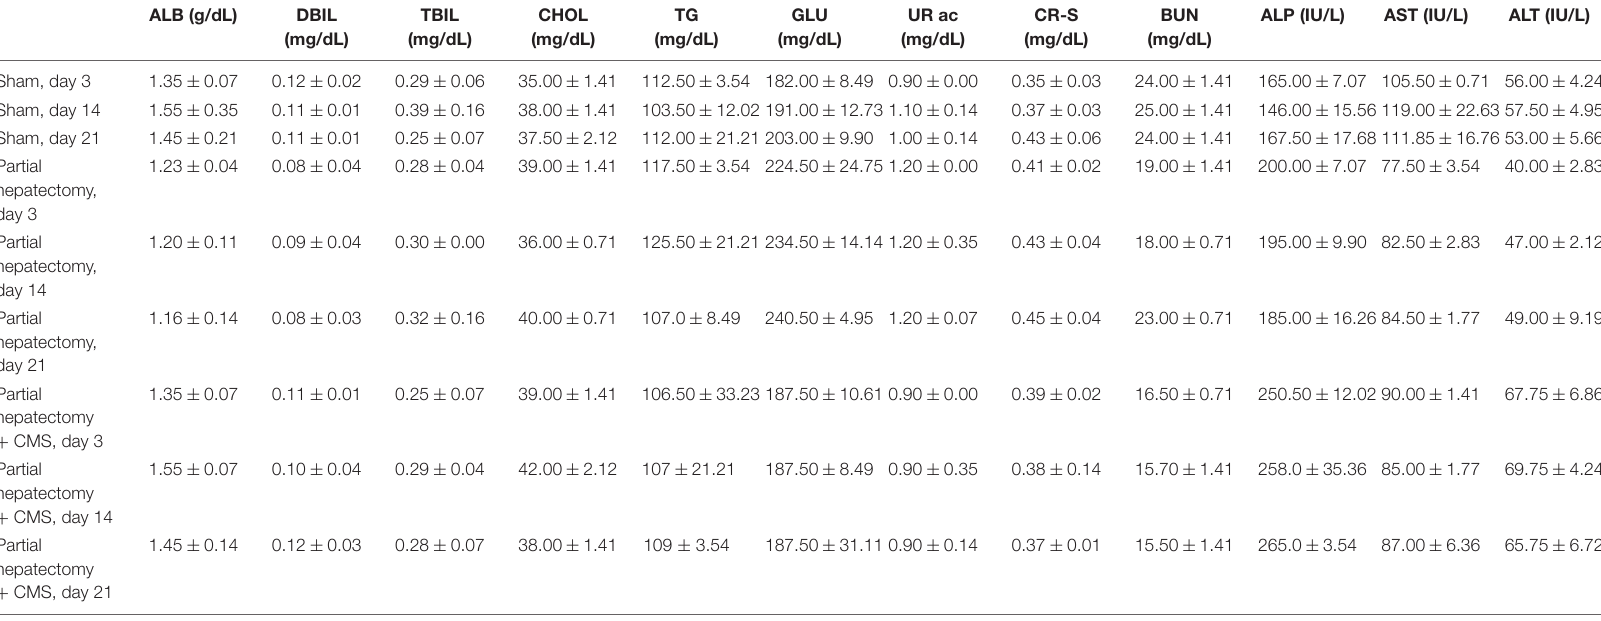
TABLE 1 | Biochemical parameters evaluated in the sham, PH, and PH + CMS groups on days 3, 14, and